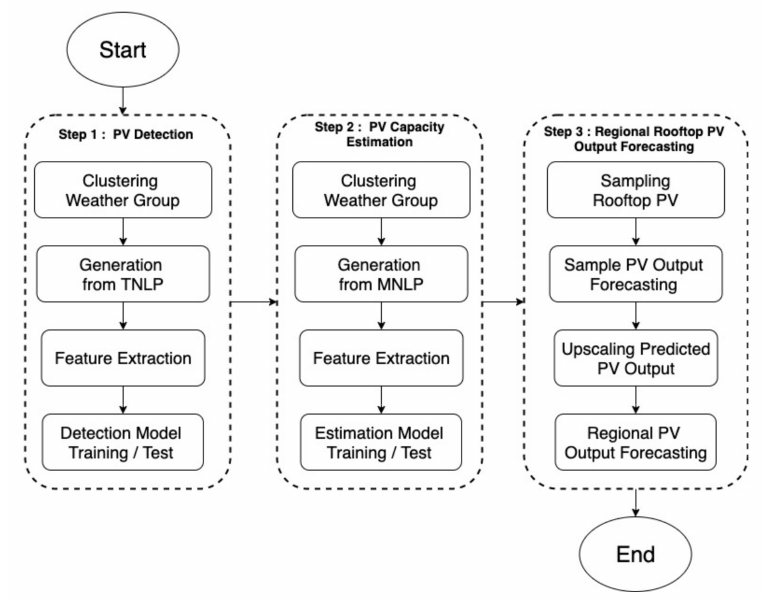
Figure 2. Framework of the proposed regional rooftop PV forecasting